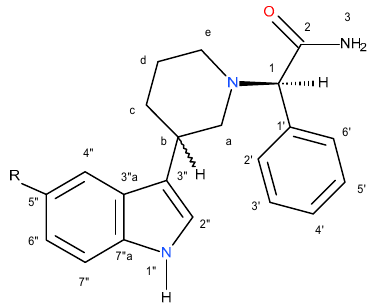
Figure 8. Numbering system for NMR spectra interpretation of compounds (3R,2R)-4a , (3S,2R) - 5a , (3R,2R) - 6b , (3S,2R) - 7b , (3R,2R) - 8c and (3S,2R) - 9c.